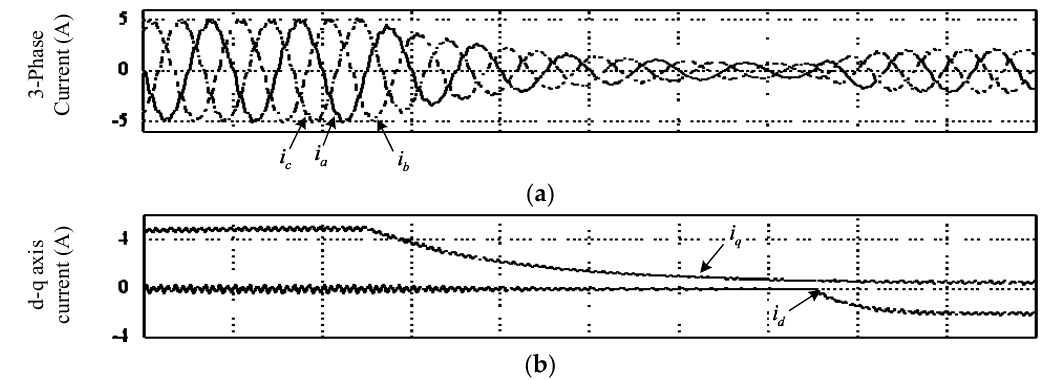
Figure 21. Simulation results without DTCS; ( a ) three-phase currents; ( b ) d - q axis currents on the synchronous reference frame.